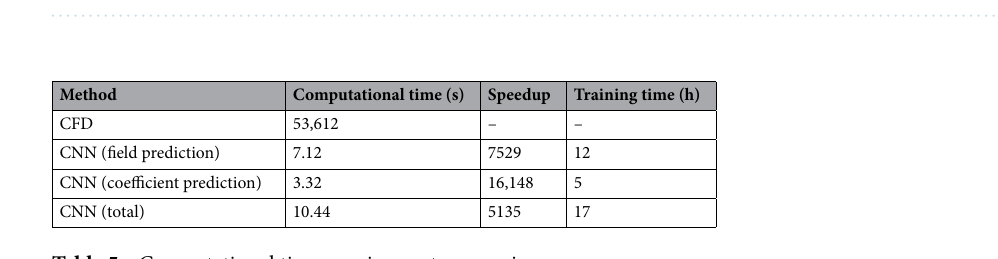
Table 5. Computational time requirement